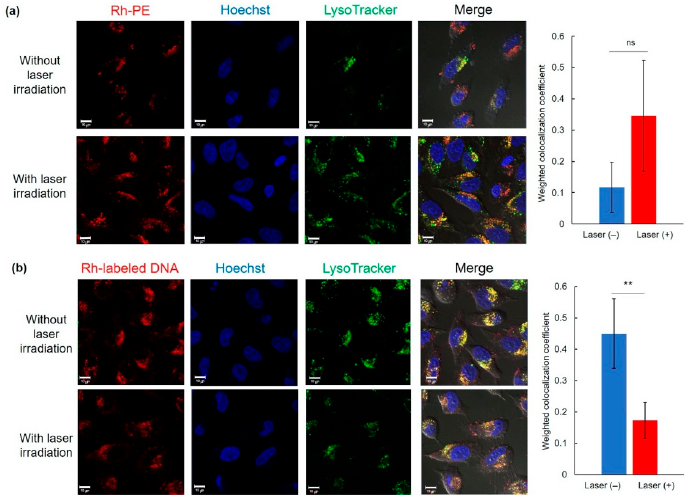
Figure 4. Effect of NIR laser irradiation on cellular association of complexes. Fluorescence intensity of HeLa cells treated with ( a ) Rh-labeled pDNA-containing complexes or ( b ) Rh-PE-containing complexes for 24 h with or without 1 min-NIR laser irradiation at 1 h after complex apply ( n = 2). Statistical analyses were done using a two-tailed Student’s t -test. ns: not significant.